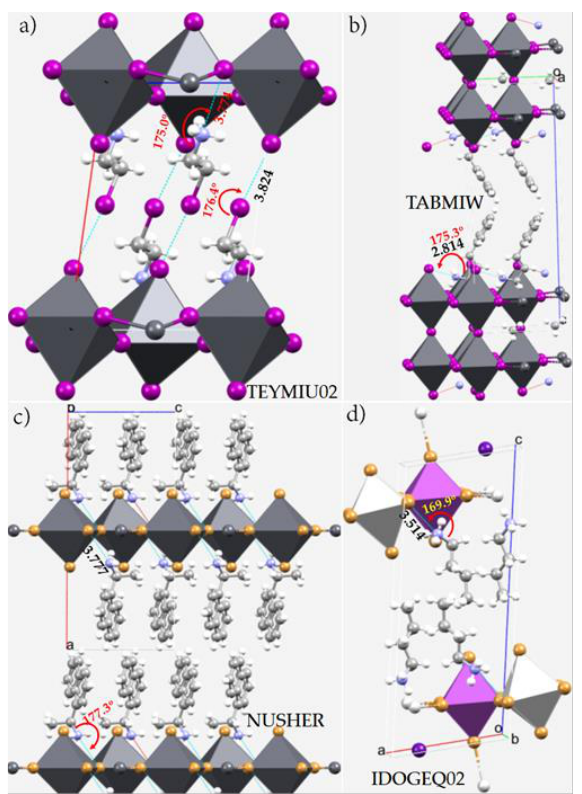
Figure 17. Polyhedral and ball-and-stick models of some crystals featuring highly directional N···X (X = Br, I) pnictogen bonding interactions. ( a ) (I−(CH 2 ) 2 −NH 3 ) 2 PbI 4 [136]; ( b ) 2(C 9 H 12 N),0.5(C 2 H 6 ),0.5(Pb 4 I 14 ) [137]; ( c ) 2(C 12 H 14 N)(PbBr 4 ) n [138]; and ( d ) (BA) 2 CsAgBiBr 7 (BA = CH 3 (CH 2 ) 3 NH 3+ ) [139]. Intermolecular interactions are marked as dotted lines in cyan. Selected bond distances and bond angles are in Å and degrees, respectively. CSD references are shown in upper-case letters. The gray-white, purple and gray polyhedra represent the octahedral nature of Ag, Bi and Pb cations, respectively. Other than the two types of interactions formed by the ammonium head mentioned above, we found that part of the stability of the system is driven by the attractive interac- tion of iodine in I−(CH 2 ) 2 −NH 3+ and the inorganic framework. As shown in Figures 17a and 18a, these are nothing other than charge assisted C – I···I halogen bonds and C – H···I hydrogen bonds. The first are stronger than the second, inferred from the intermolecular